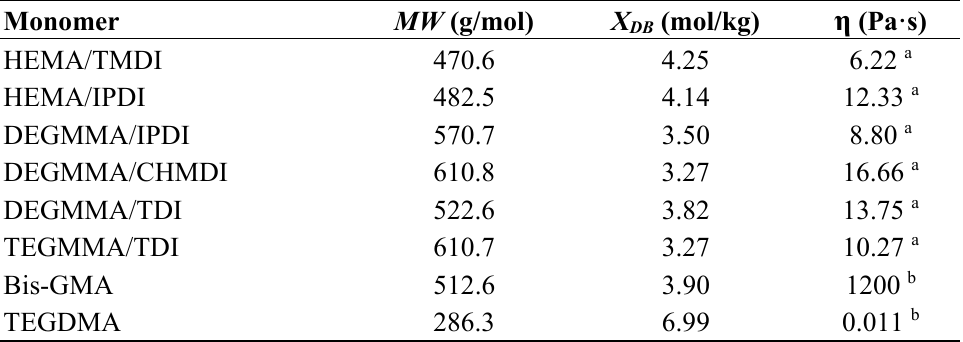
Table 1. The properties of used dimethacrylates: molecular weight ( MW ), concentration of double bonds ( X DB ), viscosity ( η